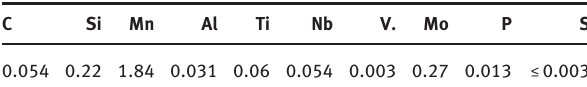
Table 1: Chemical composition of BS700MC super steel (wt%).